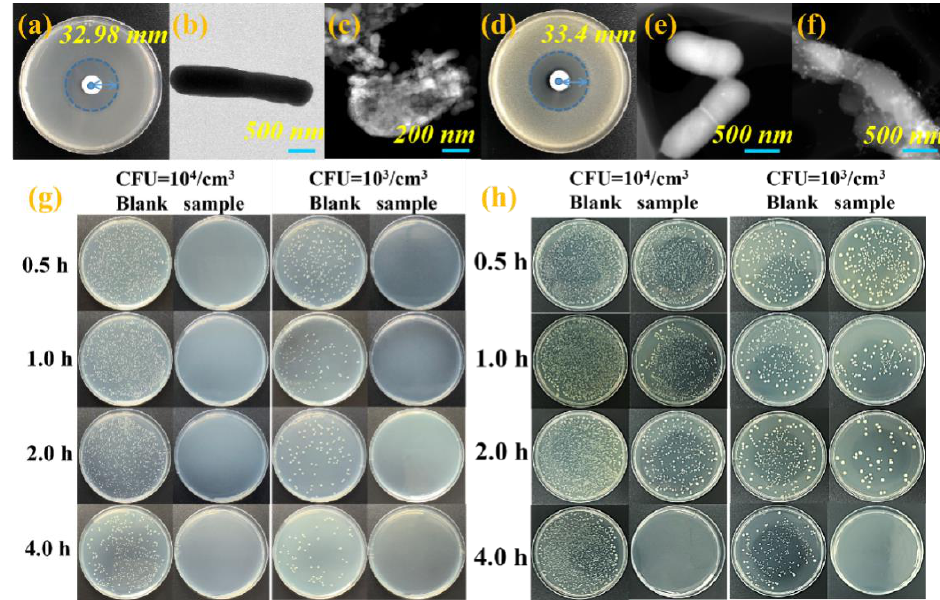
Figure 2. The killing efficiency of the ZIF-L, ( a ) inhibition zone toward Bacillus subtilis , ( b ) the TEM of Bacillus subtilis , ( c ) the TEM of ZIF-L treated Bacillus subtilis , ( d ) inhibition zone toward Escherichia coli , ( e ) TEM of Escherichia coli ., ( f ) TEM of ZIF-L treated Escherichia coli , ( g ) photographs of colonies toward Bacillus subtilis , ( h ) photographs of colonies toward Escherichia coli .